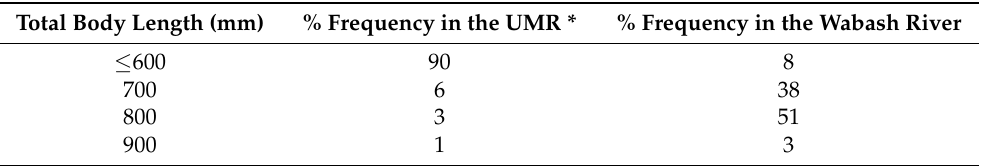
Figure 3. Monthly discharge at LD 8 based on 50%, 25%, 5%, and 1% exceedance durations between 1972–2000 [47]. Open- river conditions start when discharge is greater than 2718 m 3 /s. Open-river conditions start when discharge is greater than 2718 m 3 /s. Table 3. Length-frequency distributions of silver carp (by 100 mm length increment) from the Upper Mississippi River (UMR) and Wabash River